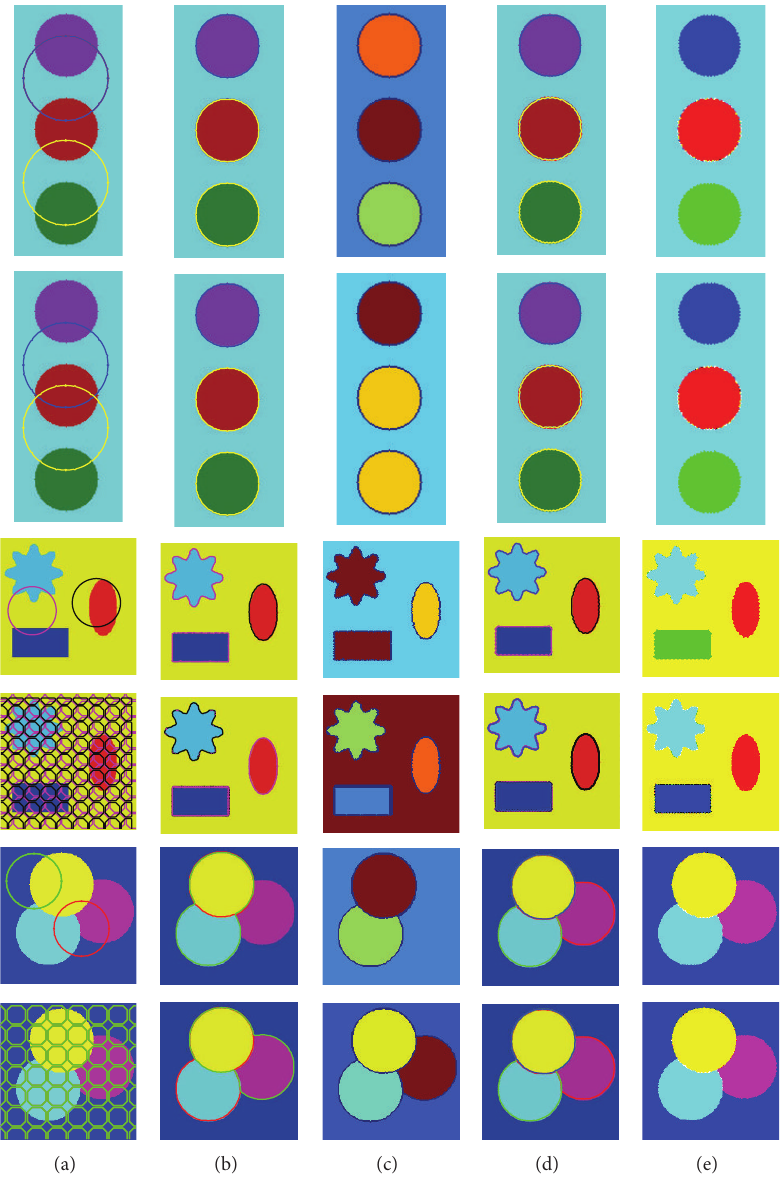
Figure 4: Results for synthetic images with two different initial contours. (a) The two different initial contours; (b) the corresponding final contours of the FMLSM model; (c) the corresponding final labeled images of the FMLSM model; (d) the corresponding final contours of the proposed model; (e) the corresponding final labeled images of the proposed